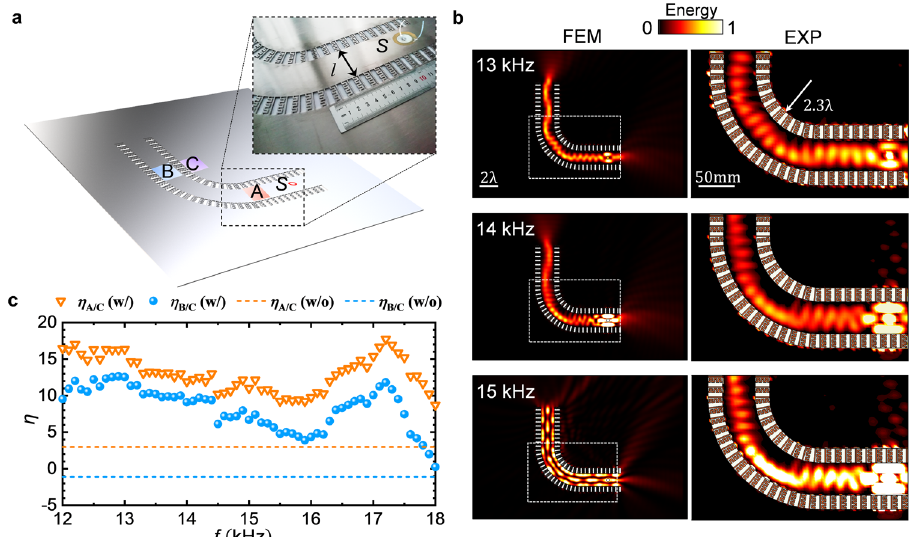
Fig. 3 Experimental veri fi cation of ef fi cient waveguide. a Sample of an ultrathin “ L ” -shaped waveguide made of metagratings. A piezoelectric wafer is bonded at point S to generate omnidirectional fl exural waves. b Experimentally measured (EXP) and simulated (FEM) energy fi elds of the waveguide at 13 – 15 kHz. The tested region is framed by the white dashed box. The scale bars are suitable for all EXP and FEM data. c Contrast ratios η A = C and η B = C as a function of frequency f . The subscripts A, B, C refer to regions marked in ( a ). Dots refer to the measured contrast ratio with (w/) the waveguide. Dashed curves refer to the theoretical contrast ratio without (w/o)